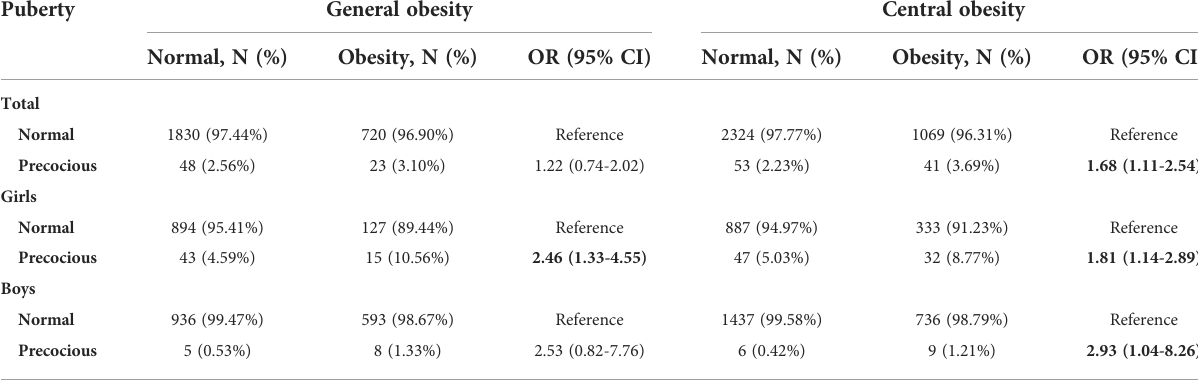
TABLE 3 Associations between different types of obesity and the risk of precocious